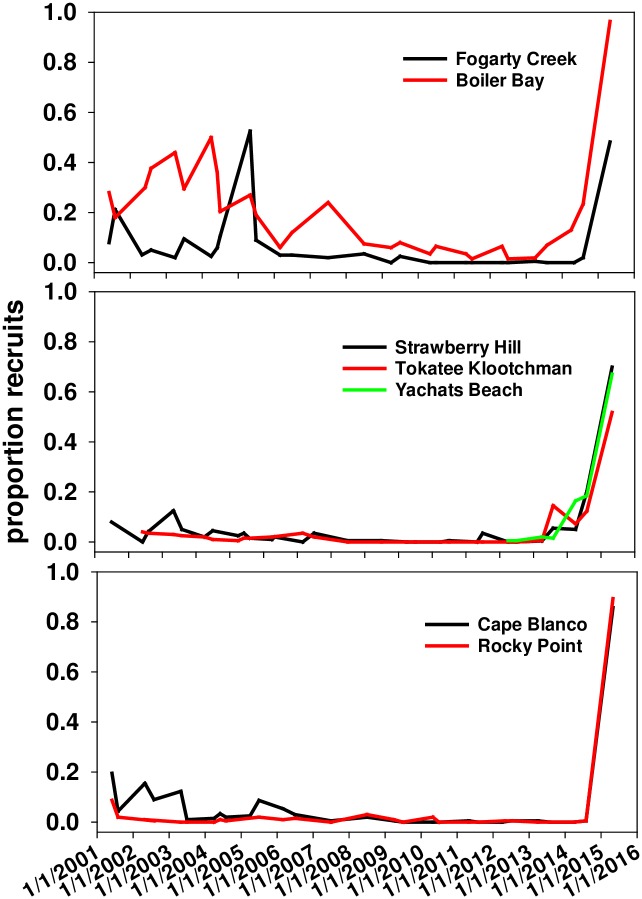
Average (+ 1SE) proportion of recruits of P. ochraceus over time at seven sites.Sample sizes were ~200 individuals per site per sample date. See Methods for details.